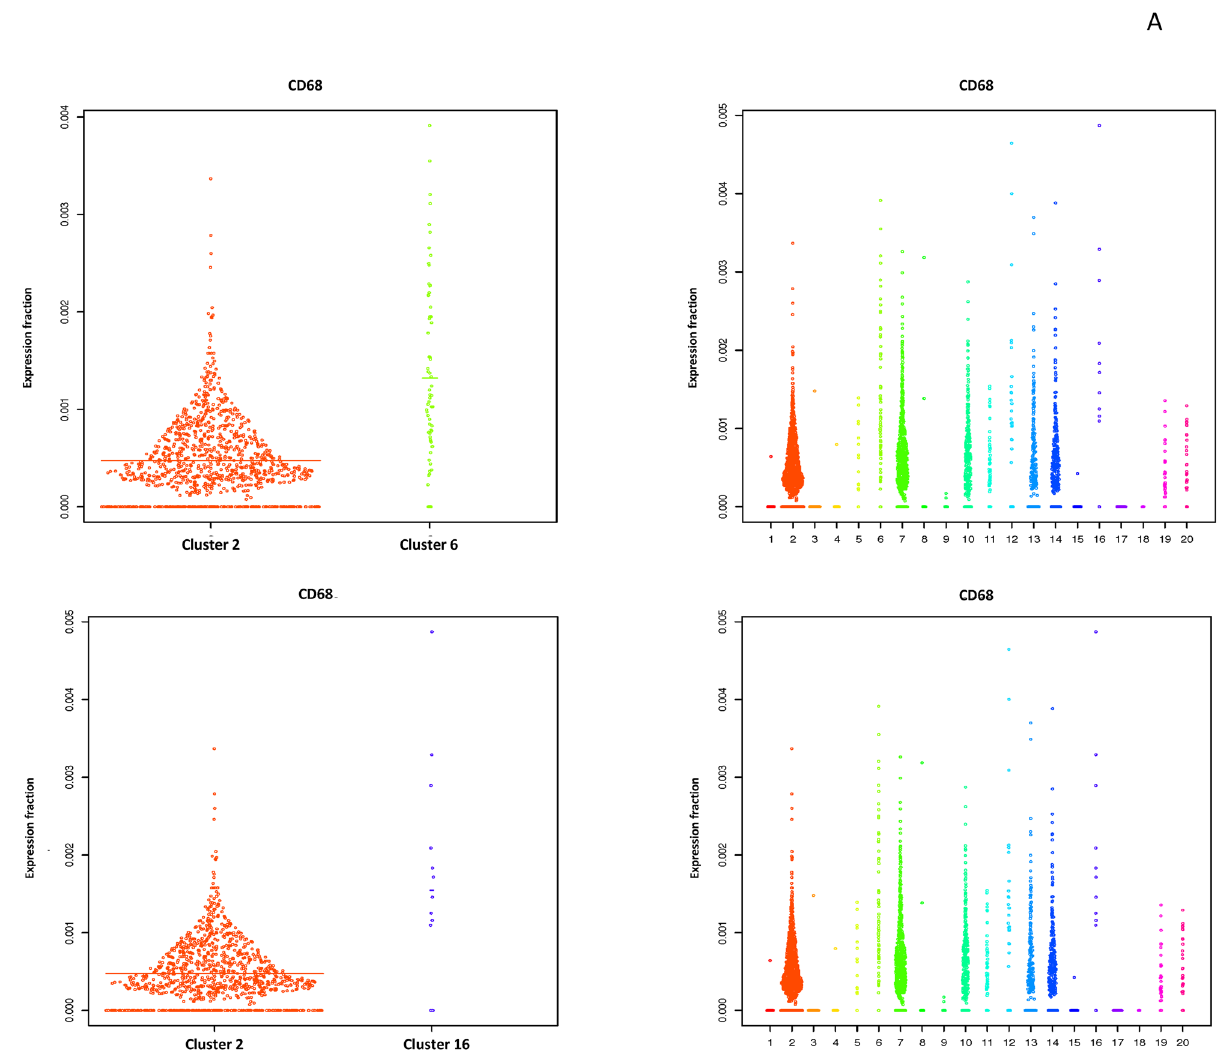
Figure 6. Violin plots: ( A ) comparing CD68 expression cluster 2 with cluster 6, cluster 2 with cluster 16. ( B ) Comparing key genes expressed in clusters 6 and